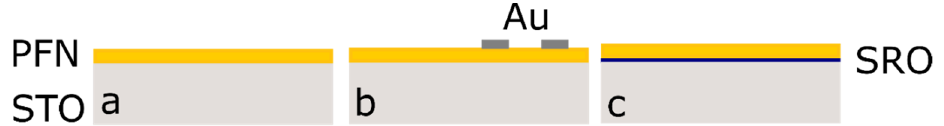
Figure 1. Different sample structures for the different measurements: ( a ) for XRD, RHEED, and UV-Vis; ( b ) for TLM; ( c ) for IPES/UPS.